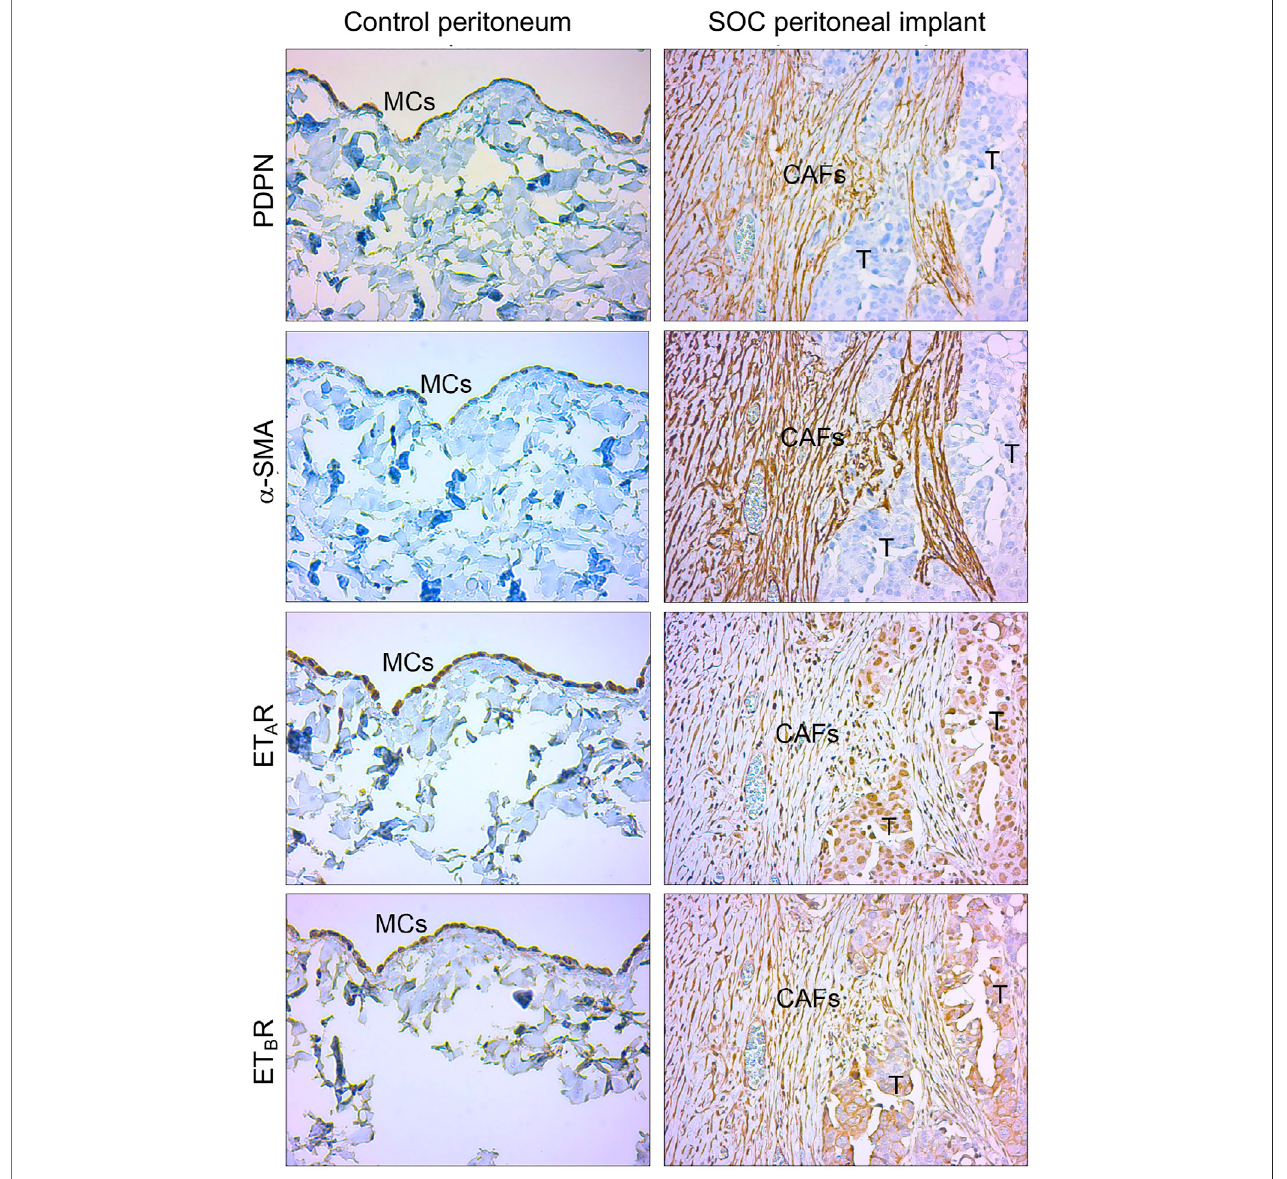
FIGURE 9 | ET-1 receptors are co-expressed with MMT markers in human SOC peritoneal implants. Representative images of IHC analysis of control peritoneum and SOC peritoneal implant sections, stained for ET-1 receptors (ET A R, ET B R) and MMT markers (PDPN and α -SMA).